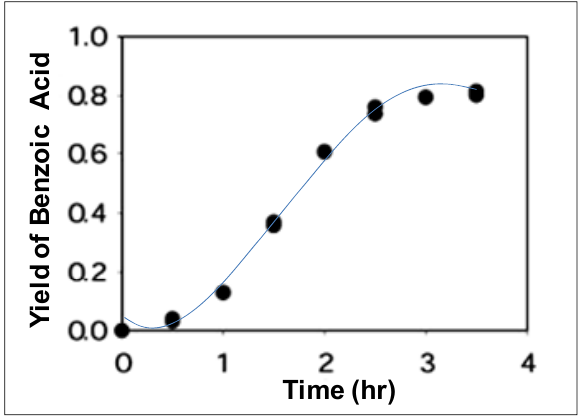
Figure 15. Conversion of n -propyl benzoate to benzoic acid and propanol in NCW at 250 °C [70].